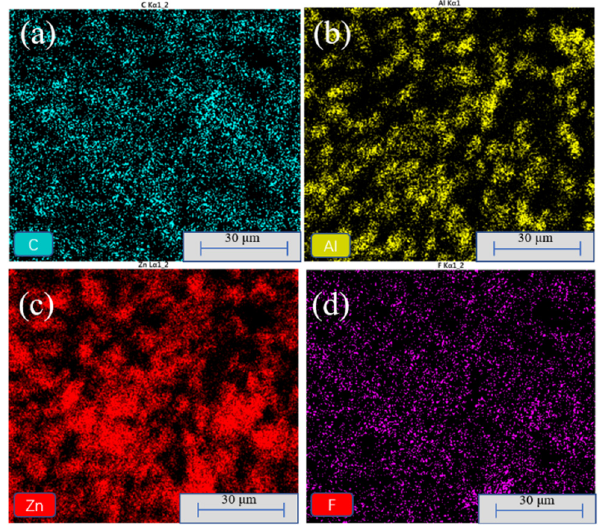
Figure 3. EDS analysis of the biomimetic superhydrophobic films modified by F 16 CuPc ( a ) C, ( b ) Al, ( c ) Zn, and ( d ) F elements.